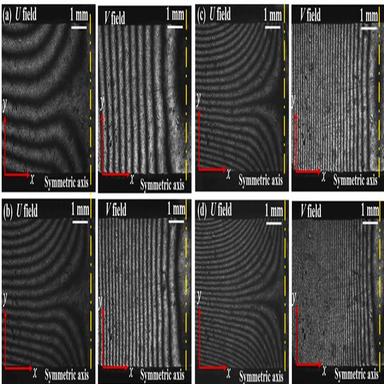
Moir´e interferometric fringe patterns under three-point bending loads of (a) 18 N, (b) 36 N, (c) 52 N, and (d) 70 N. The copyright permission for this figure has been granted.